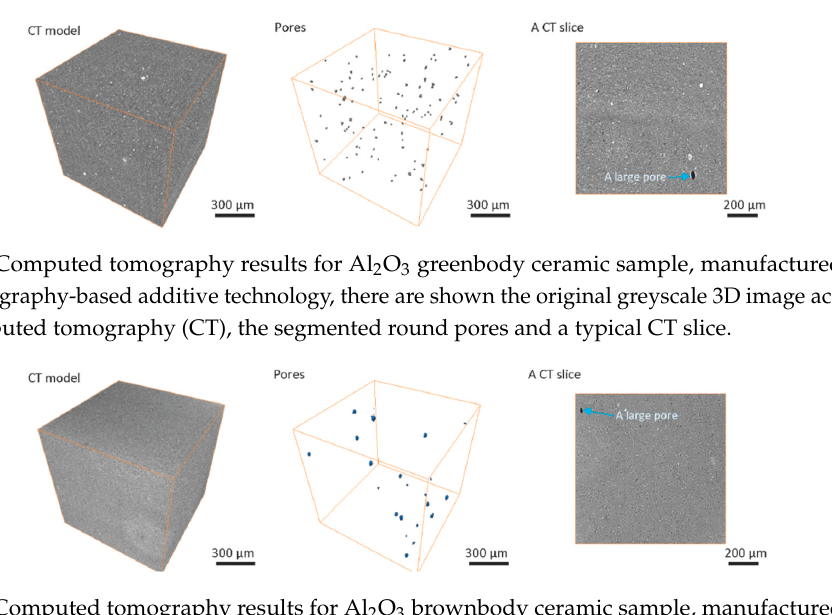
Figure 3. Computed tomography results for Al ₂ O ₃ brownbody ceramic sample, manufactured with stereolithography-based additive technology, there are shown the original greyscale 3D image acquired with computed tomography (CT), the segmented round pores and a typical CT slice.